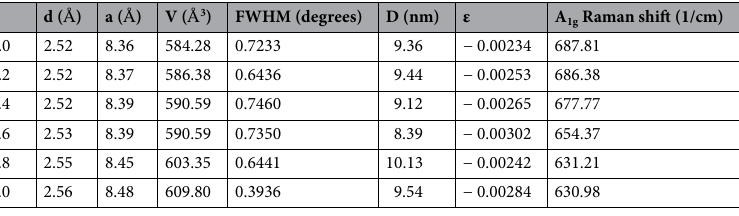
Table 2. Lattice parameter a , inter-planar spacing d , FWHM, crystal size D , strain ε , unit cell volume V , A 1g Raman shift for the Ni 1−x Mn x Fe 2 O 4 samples.